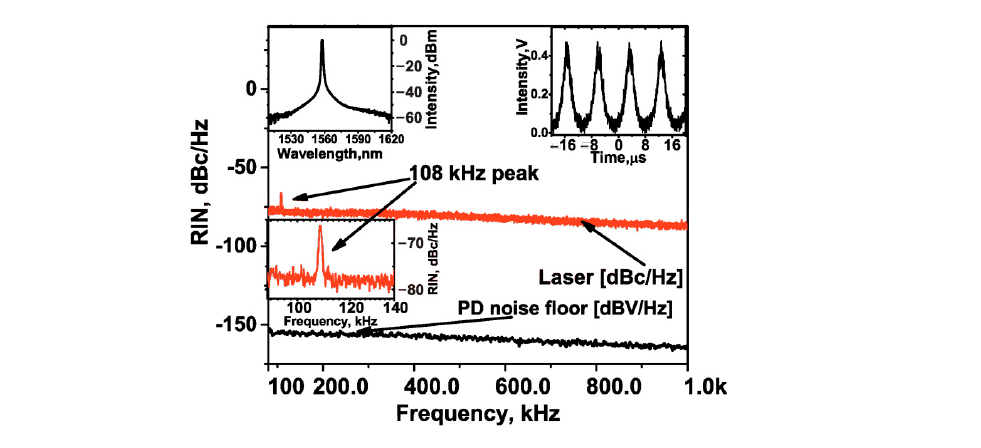
Figure 6. RIN of the Q-switching operation mode and photodetector (PD) + ESA noise floor. Inset: optical spectrum and output pulse trace.